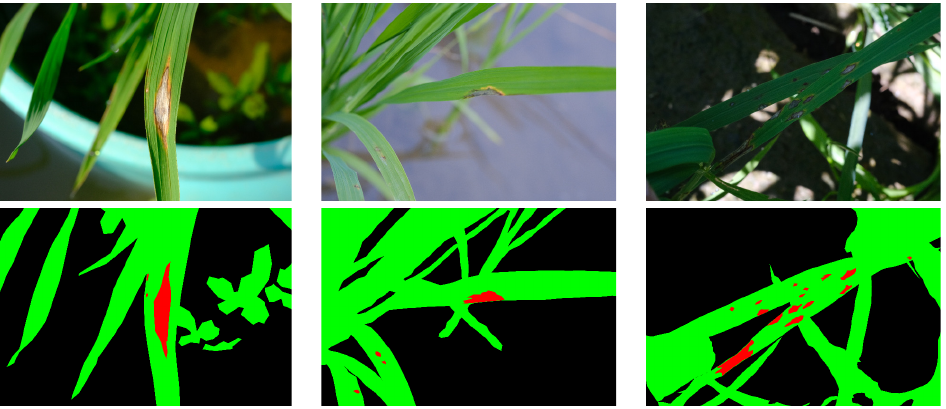
Figure 4. Sample images of Rice blast: source images ( upper ) and GT images ( lower ).